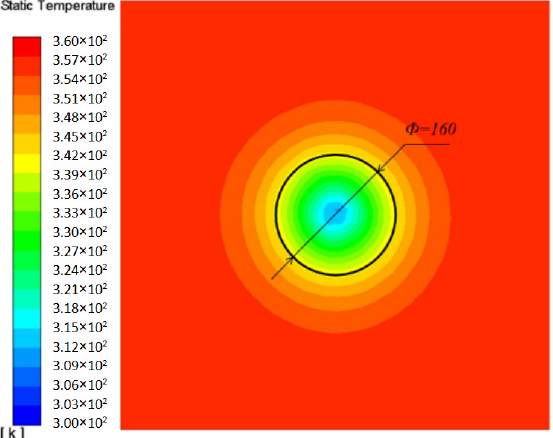
Figure 3. Temperature of test surface with a single nozzle at the 30th second.